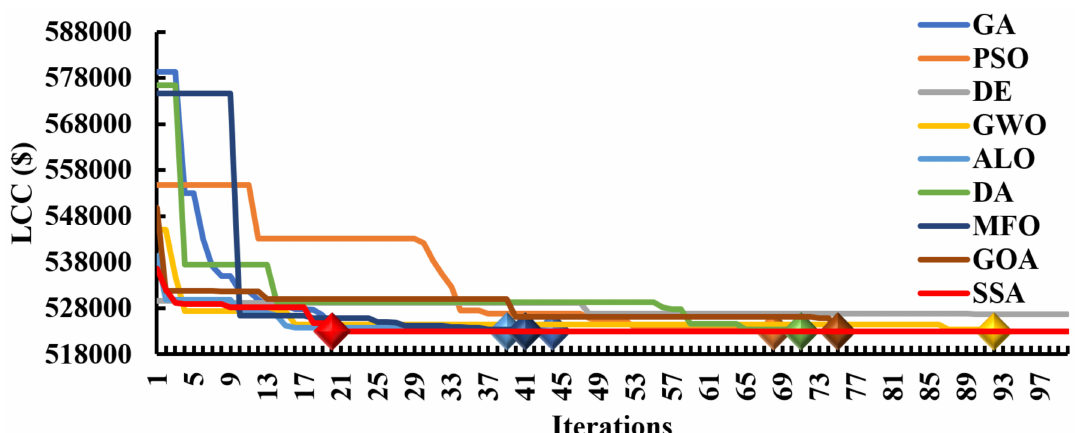
Figure 22. Convergence curves of Ni-Fe based IHRES with